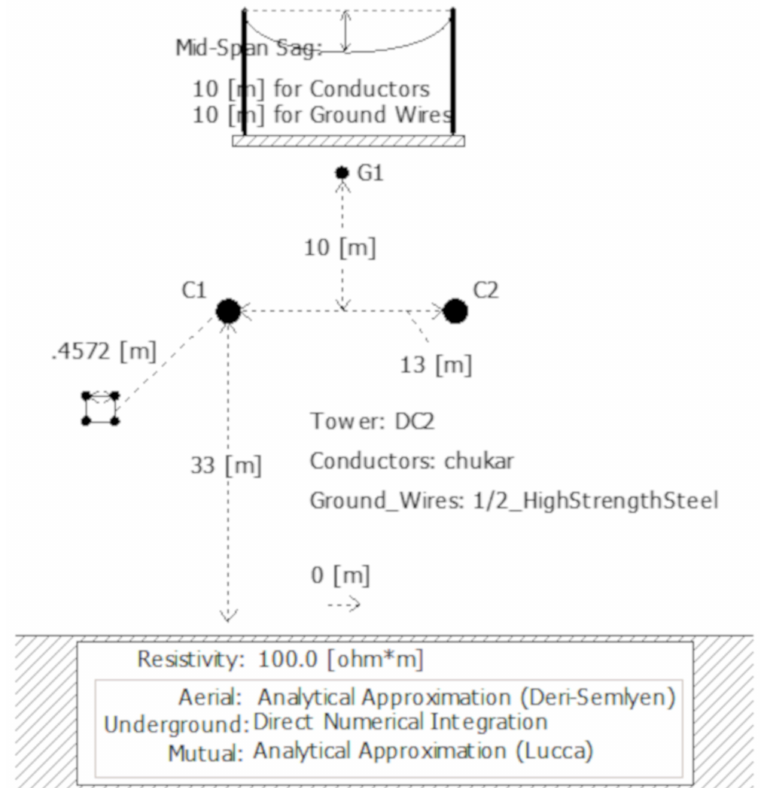
Figure A2. Tower data of the MMC-HVDC transmission